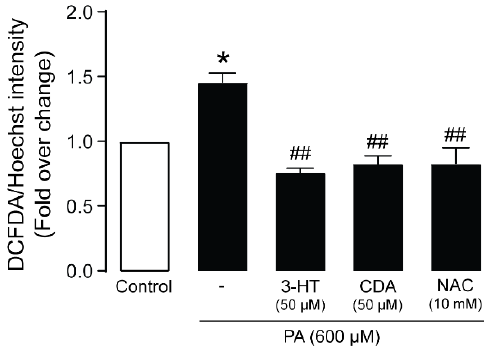
Figure 6. 3 ‐ Hydroxyterphenyllin (3 ‐ HT) and candidusin A (CDA) attenuate reactive oxygen species (ROS) generation induced by palmitic acid (PA) in human podocytes. The level of ROS formation was measured by using the 2 ′ ,7 ′‐ dichlorofluorescin diacetate (DCFDA) fluorescent dye. Podocytes were seeded on 96 ‐ well black plates for 24 h before treatment with 600 μ M PA and 3 ‐ HT or CDA at 50 μ M, plus a vehicle (control) for another 24 h. N ‐ acetylcysteine (NAC) (10 mM) was used as the positive control. The data are expressed as the mean intensity of DCFDA fluorescence/Hoechst ± standard error of the mean ( n = 5). * p < 0.05 compared with the control group; ## p < 0.01 compared with the PA ‐ treated group.